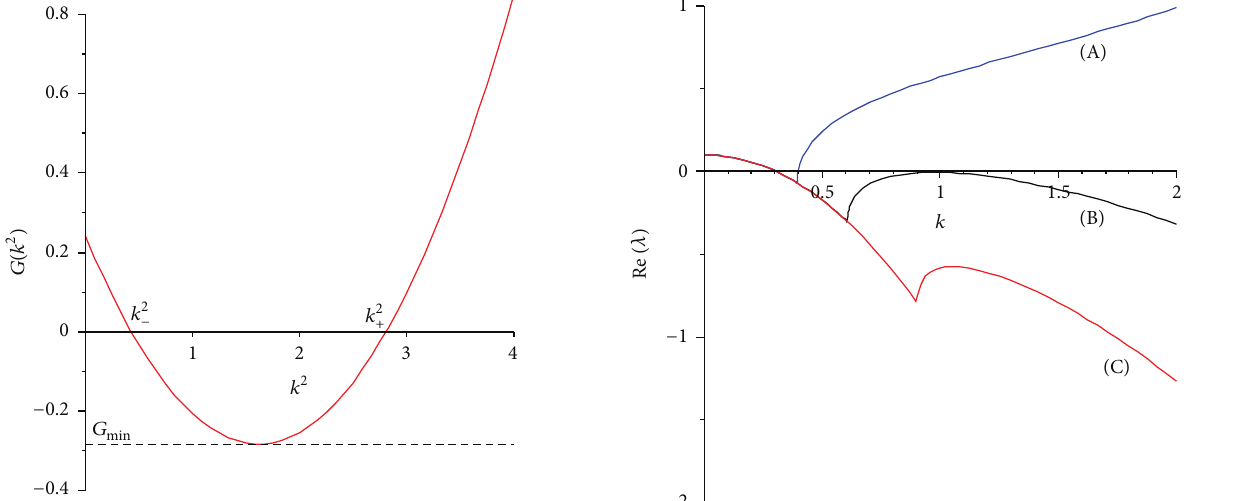
𝐷 = 12 = 0.4 > 𝐷 T 12 12 , the